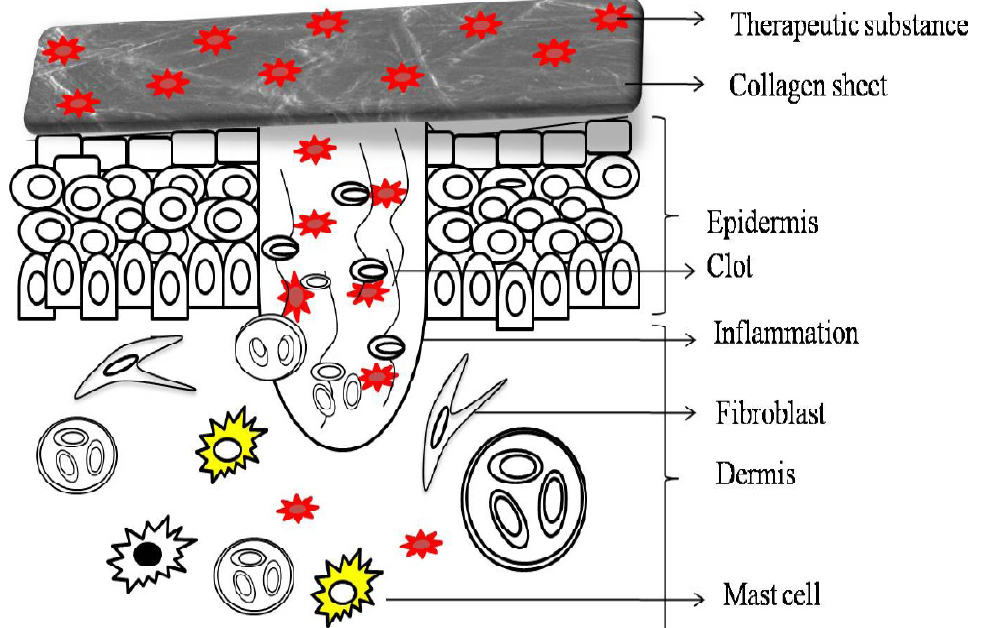
Fig. 2 . Schematic diagram depicting the release of therapeutic substance from a collagen sheet to aid wound